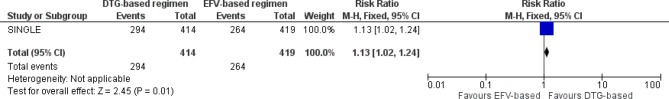
DTG + two NRTI vs. EFV + two NRTIs.Viral suppression to non-detectable (<50 copies/mL) at 144 weeks.